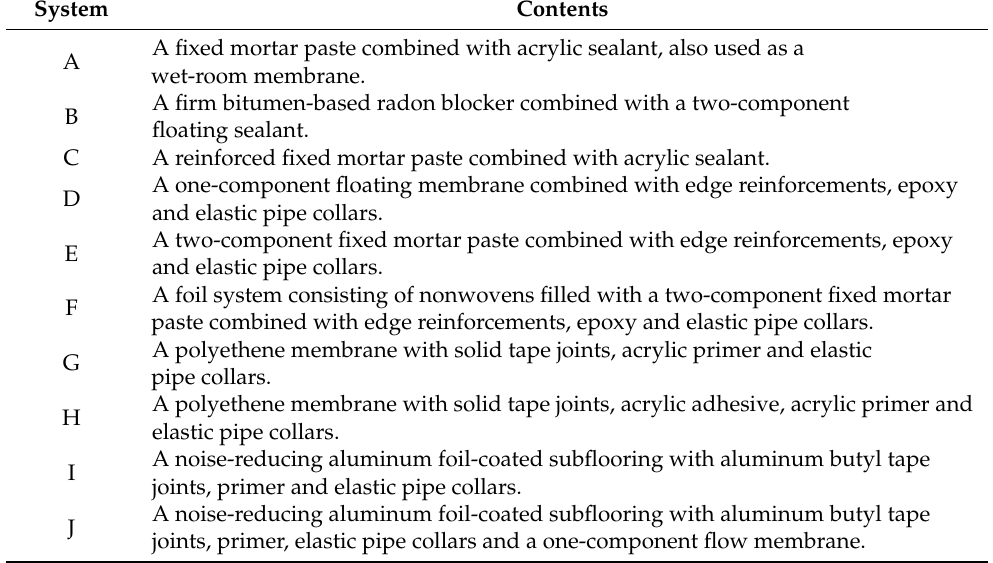
Table 2. Barrier systems tested.